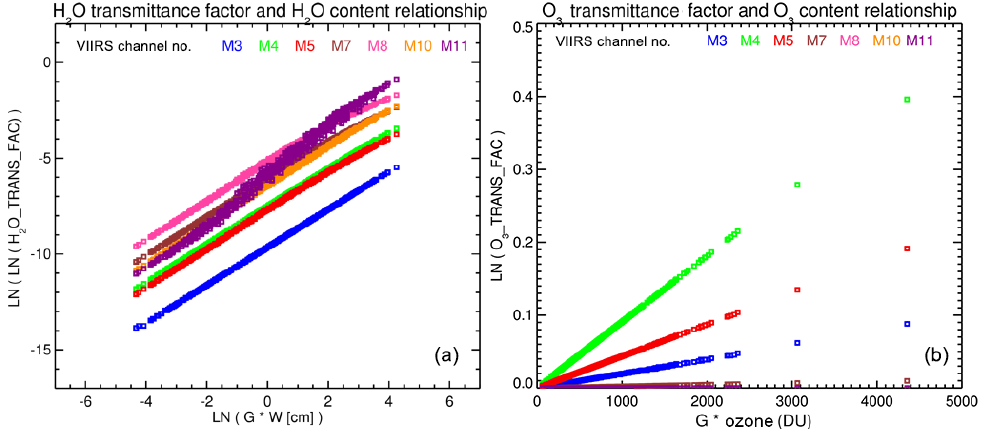
Figure 4. Relationship between gas transmittance factor and gas content in the seven VIIRS channels: (a) for H 2 O and (b) for O 3 . Gas content is scaled by the air mass factor ( G ). Gas transmittance was calculated for 52 water vapor and ozone profiles (varying gas concentration) and 10 viewing zenith angles (air mass factors) ranging from 0 to 80 ◦ . These wavelength-dependent empirical relationships are used by the DT aerosol retrieval algorithm for atmospheric gas